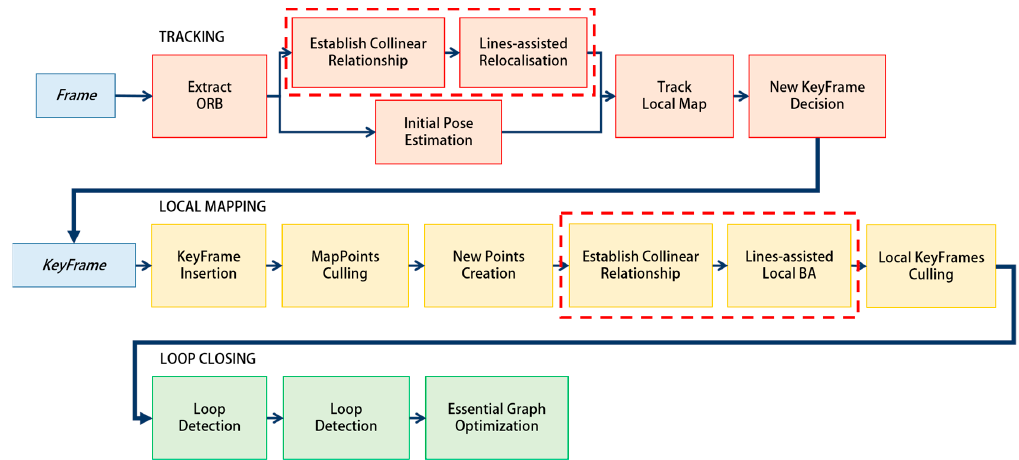
Figure 2. LAP-SLAM pipeline is an extension of that of ORB-SLAM [3]. The system consists of three main threads: Tracking thread, local mapping thread, and loop closing thread. The tracking thread estimates the position and pose of the camera, and makes the decision of adding new keyframes. Then, the local mapping thread adds the new keyframe into the map and optimizes the information in the local map with BA. The additional line-assisted operations are mainly added in this thread. The loop closing thread is in charge of checking for loops and correcting the accumulated error through loop closure. The two blocks surrounded by red dashed rectangles are the main novel work of this